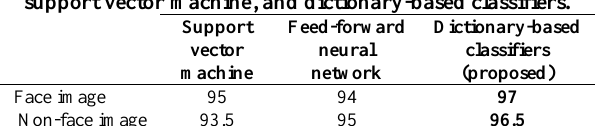
Table 1. Classification accuracy rate for face and non-face images based on HOG feature for neural network, support vector machine, and dictionary-based classifiers.